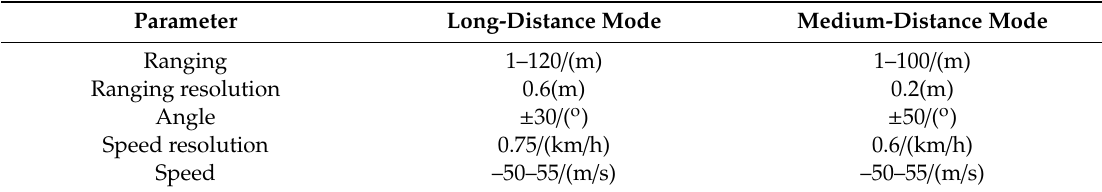
Table 1. Main technical parameters of the millimeter-wave radar. Parameter Long-Distance Mode Medium-Distance Mode Ranging